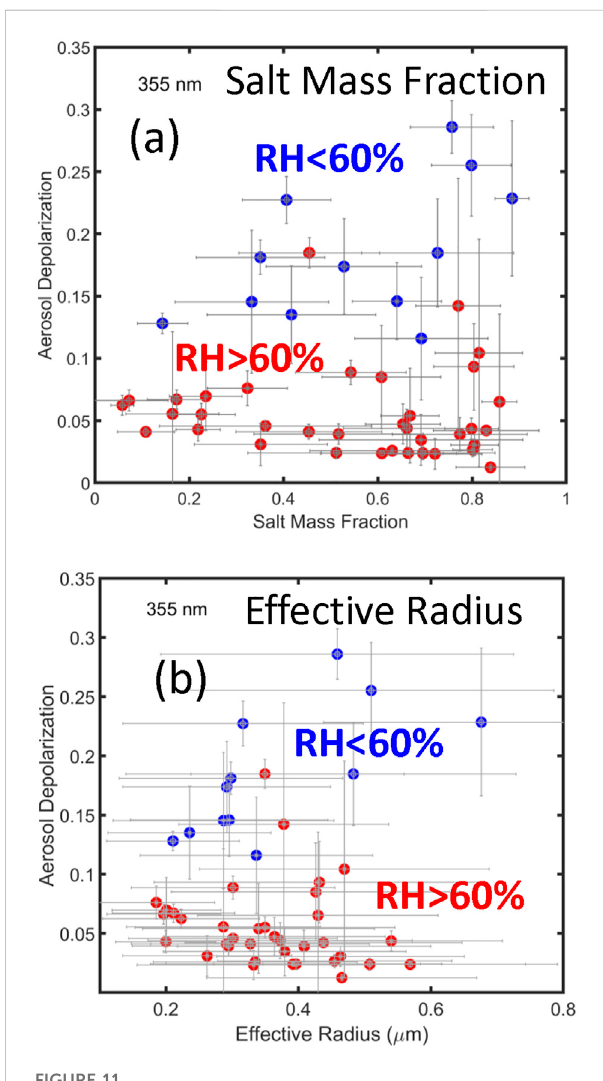
HSRL-2 measurements of aerosol depolarization at 355 nm vs. (A) salt mass fraction derived from the PILS and AMS measurements for RH < 60% (blue) and RH > 60% (red) and (B) effective radii (dry) derived from the LAS measurements for RH < 60% (blue) and RH > 60% (red). Each point represents the average of each fl ight and error bars represent the standard deviation over the fl ight. The Spearman rank correlation coef fi cients between aerosol depolarization and salt mass fraction are 0.66 (RH < 60%) and -0.16 (RH > 60%). The Spearman rank correlation coef fi cients between aerosol depolarization and effective radius are 0.76 (RH < 60%) and -0.24 (RH >